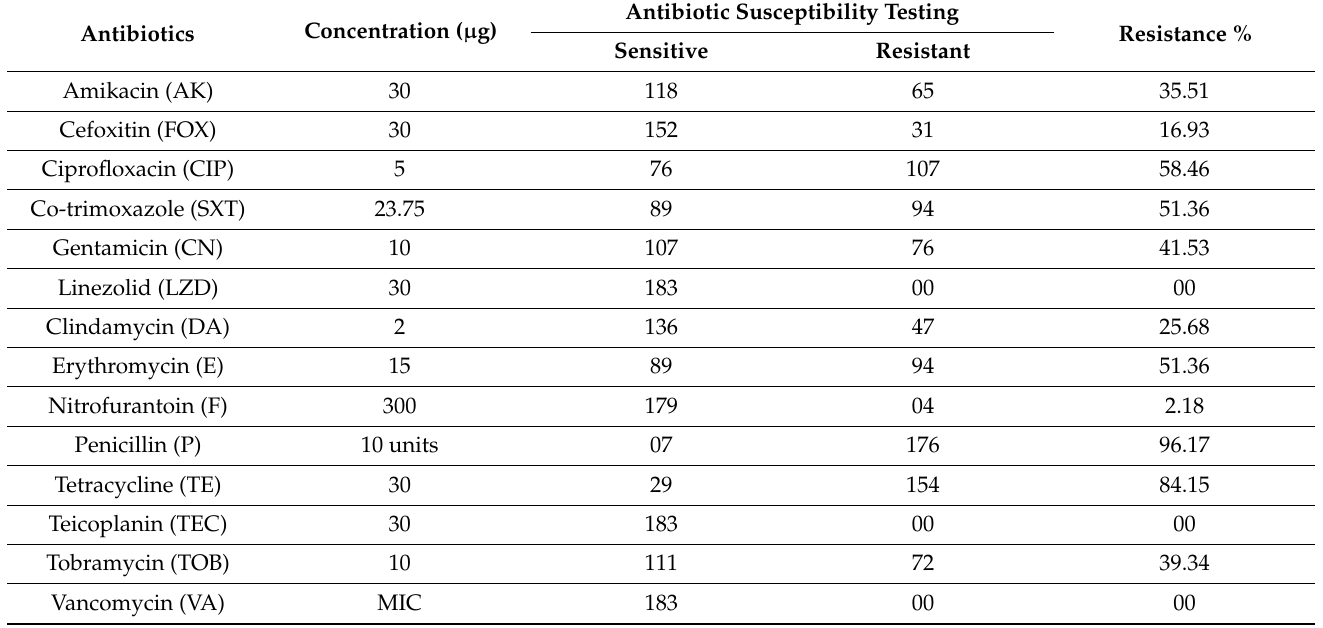
Table 3. Antibiotic resistance pattern of S. aureus ( n =